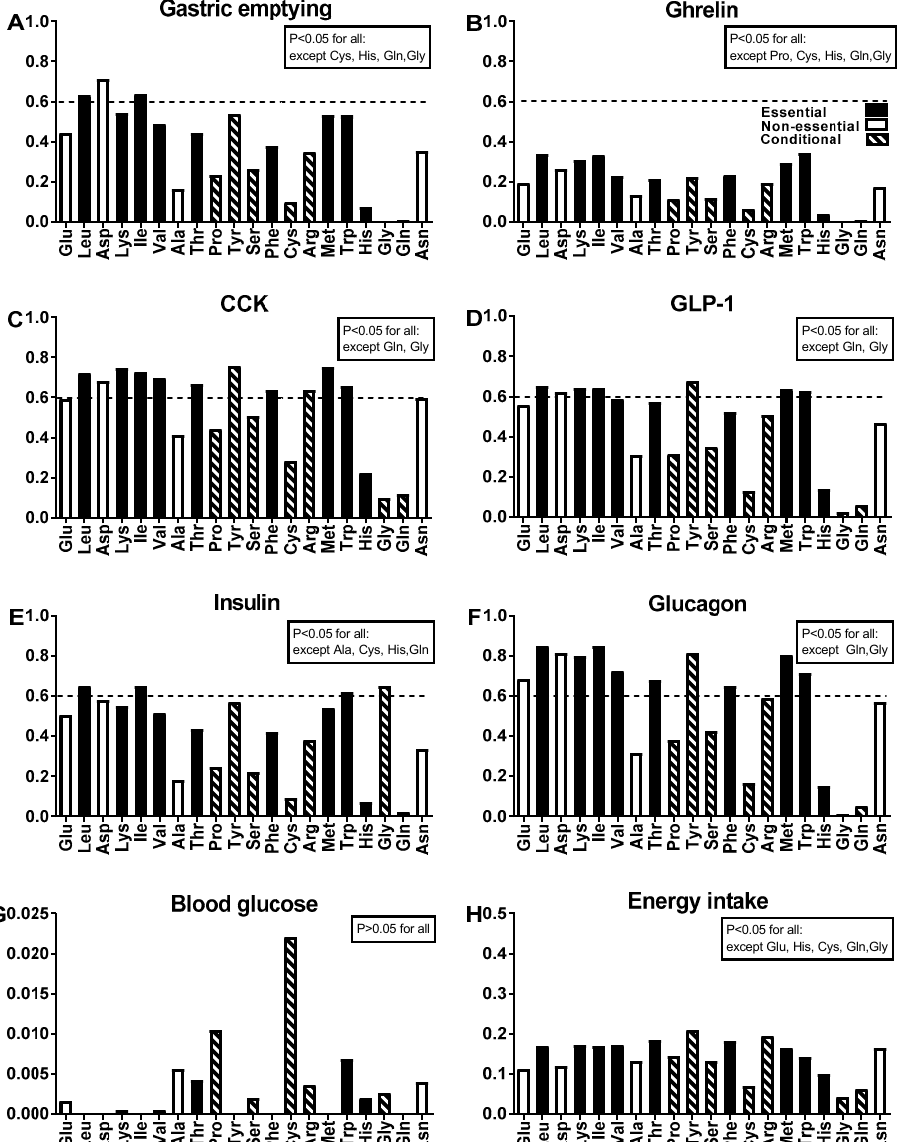
Figure 3. Within-subject relationships between the iAUCs 0–180 min of each of the 20 amino acids (displayed in order of abundance of the amino acids in the whey protein drinks) with (A) gastric emptying, as well as the iAUCs 0–180 min of (B) ghrelin, (C) CCK, (D) GLP-1, (E) insulin, (F) glucagon and (G) blood glucose and (H) energy intake, following consumption of the three test drinks which contained 0 g (C), 30 g (L), and 70 g (H) of whey protein. Data are within-subject R 2 values for n = 16; Statistical significance was accepted at p < 0.05. The hatched horizontal line indicates the specific AAs which were consistently amongst the top ~10 amino acids strongly associated (defined as having an R 2 of ≥ 0.6) with the majority of study outcomes presented in A to F except ghrelin. Abbreviations for AAs: Alanine: Ala; Arginine: Arg; Asparagine: Asn; Aspartic Acid: Asp; Cysteine: Cys; Glutamine: Gln; Glutamic acid: Glu; Glycine: Gly; Histidine: His; Isoleucine: Ile; Leucine: Leu; Lysine: Lys;